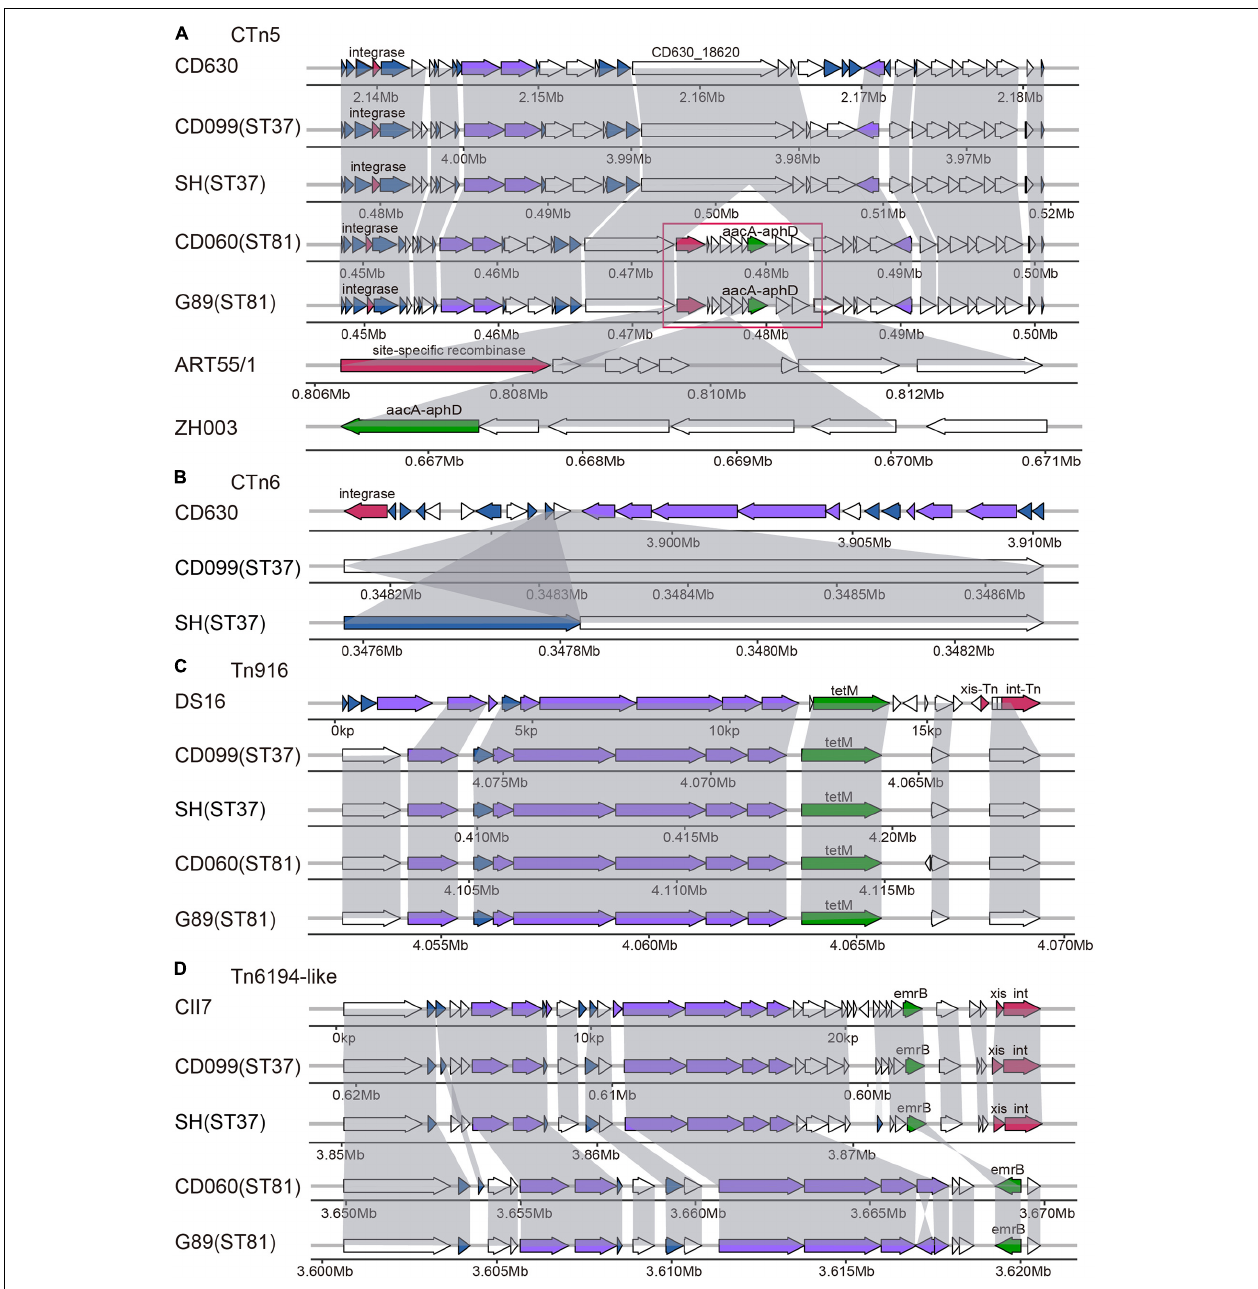
FIGURE 2 | Schematic diagram of representative ICEs in selected ST81 and ST37 isolates as well as reference strains, including CTn 5 (A) , CTn 6 (B) , Tn 916 (C) , and Tn 6194 -like (D) . ORFs involved in similar function were showed in the same color: blue, conjugative transposon protein; red, excisionase and integrase; purple, conjugation module; green, antibiotic resistant gene; white, other functions. The large insertion region in the CTn 5 is indicated by the red frame with the ORFs homologous to Coprococcus sp. ART55/1 and to Campylobacter jejuni strain